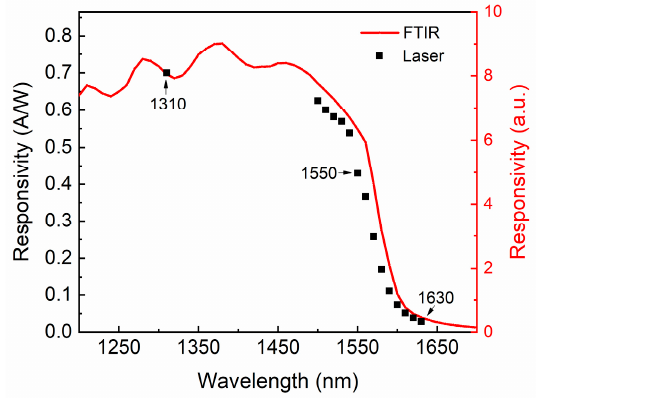
Table 3. Performance comparison for the top illuminated Ge p-i-n